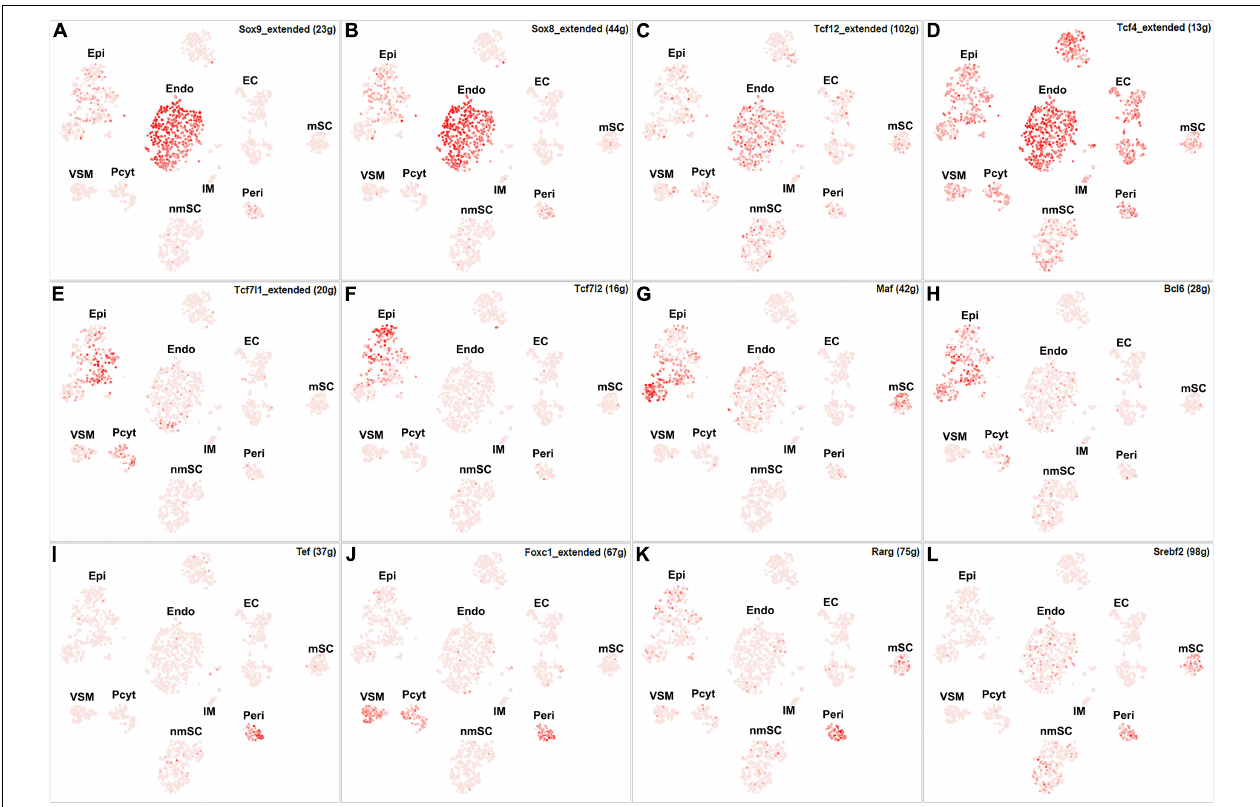
FIGURE 7 | tSNE showing regulon activity for TFs in fibroblasts. (A) Sox9, (B) Sox8, (C) Tcf12, (D) Tcf4, (E) Tcf7l1, (F) Tcf7l2, (G) Maf, (H) Bcl6, (I) Tef, (J) Foxc1, (K) Rarg and (L) Srebf2.